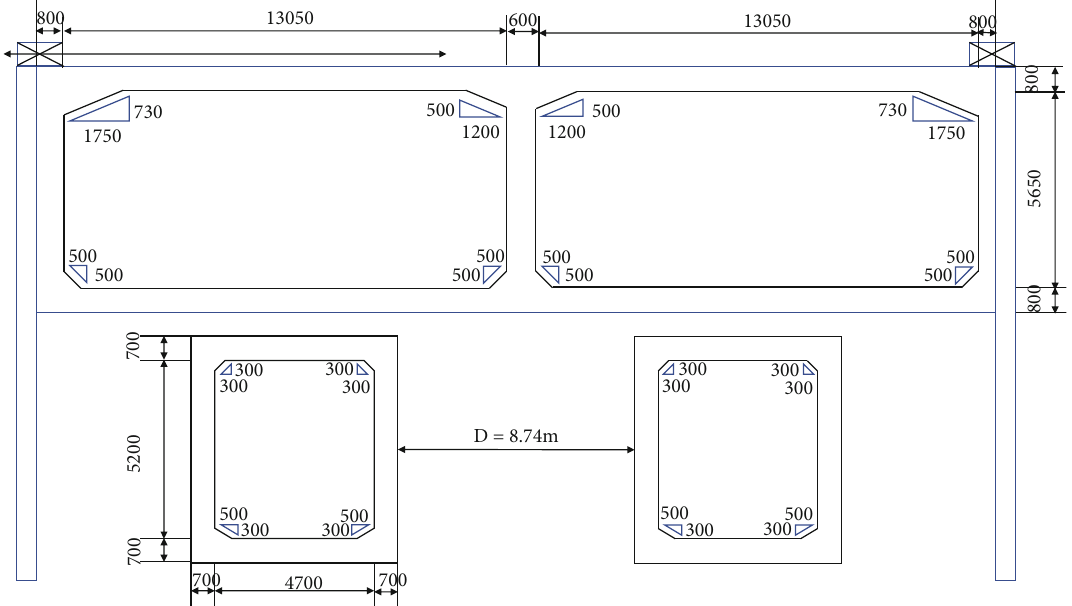
Figure 2: Speci fi c parameters of a typical section of Aixi Lake tunnel.